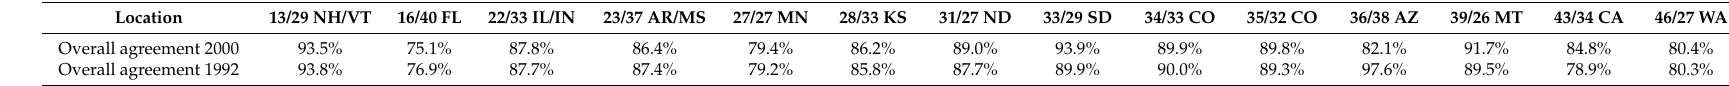
Table 3. Overall agreement per path/row for 1992 and 2000 time periods. AR = Arkansas; AZ = Arizona; CA = California; CO = Colorado; FL = Florida; IL = Illinois; IN = Indiana; KS = Kansas; MN = Minnesota; MS = Mississippi; MO = Montana; ND = North Dakota; NH = New Hampshire; SD = South Dakota; VT = Vermont; WA = Washington.